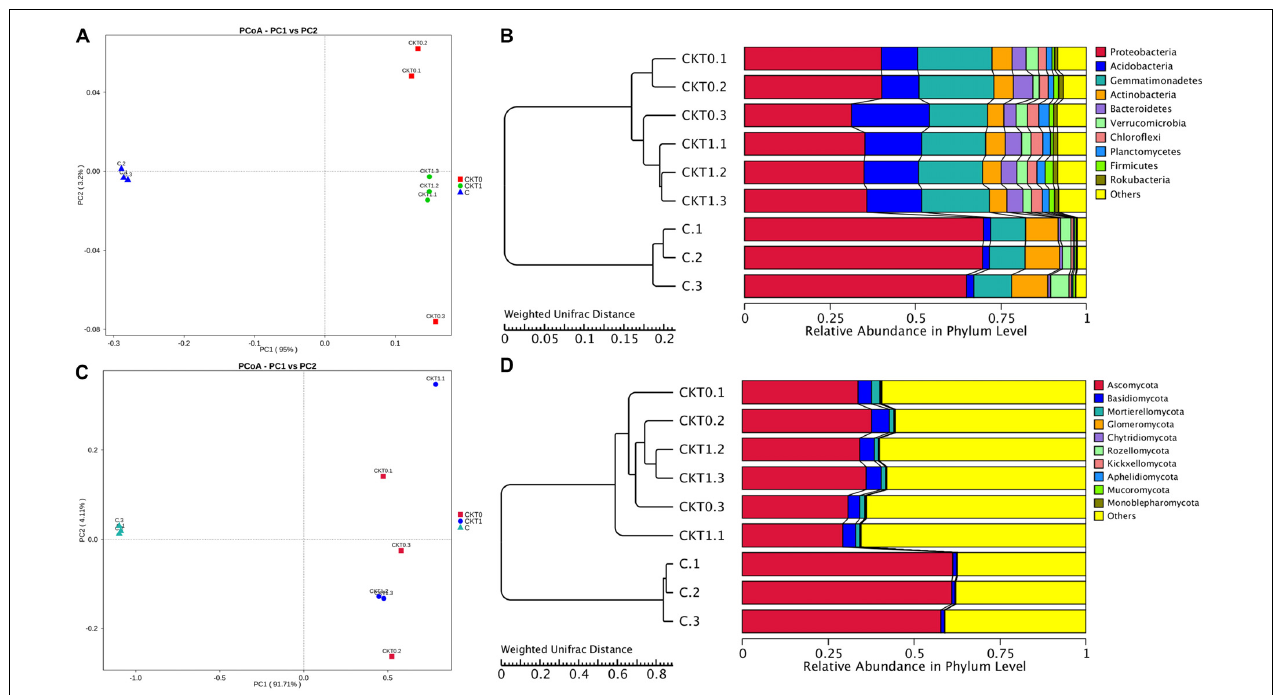
FIGURE 9 | Principal coordinate analysis (PCoA) and unweighted pair-group method with arithmetic mean (UPGMA) dendrogram of bacterial and fungal communities based on weighted unifrac distance. Soils amended with and without catalpol were incubated for 60 days at 26 ◦ C at 50% humidity. CKT0 and CKT1 represent control soil treatments without catalpol and collected at experimental initiation (T0) and termination (T1 at 60 days) of incubation, respectively. C represents treated soil amended with catalpol for 60 days and collected for analysis. Results represent the means of three replicates. (A) Principal coordinate analysis (PCoA) of bacterial communities in CKT0, CKT1, and C. (B) Unweighted pair-group method with arithmetic mean (UPGMA) dendrogram of bacterial communities in CKT0, CKT1, and C. (C) Principal coordinate analysis (PCoA) of fungal communities in CKT0, CKT1, and C. (D) Unweighted pair-group method with arithmetic mean (UPGMA) dendrogram of fungal communities in CKT0, CKT1, and